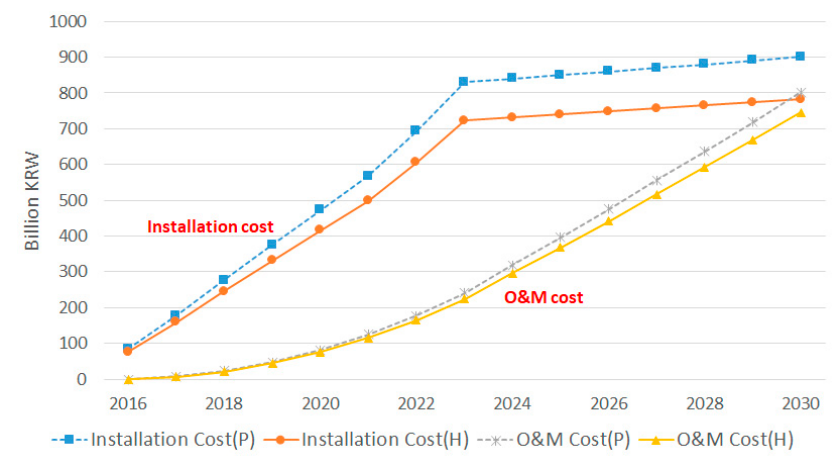
Figure 6. Comparison of Installation and O&M Cost Results per Deployment Method (P: PLC-Only, H: Hybrid).